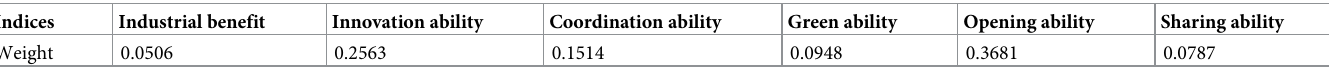
Table 2. Average weights of primary indices of industrial high-quality